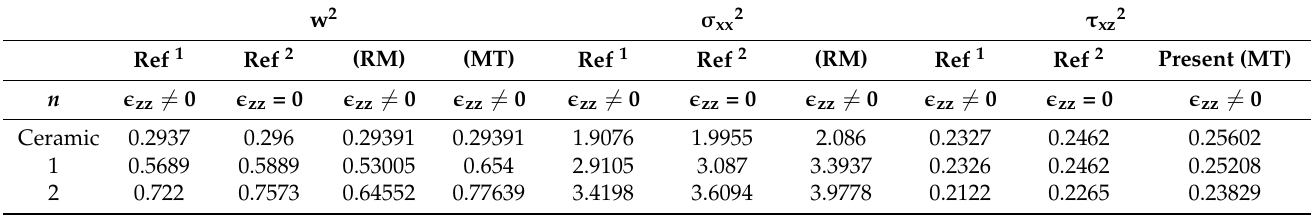
Table 4. Non-dimensional central deflection and axial stress of an FGM plate subjected to uniformly distributed load under SSSS. w